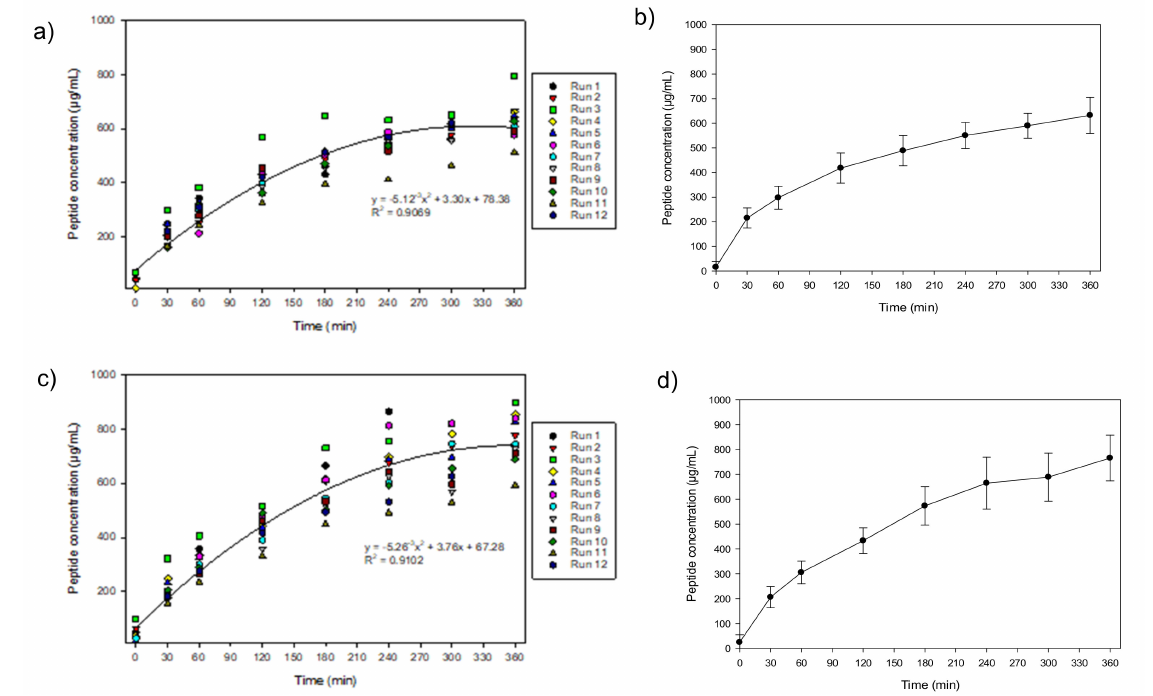
Figure 2. Migration rate of peptides for the 12 consecutive experiments in the ( a ) cationic recovery compartment (C + RC) and ( c ) anionic recovery compartment (A − RC) and average migration rate for ( b ) cationic recovery compartment (C + RC) and ( d ) anionic recovery compartment (A − RC).